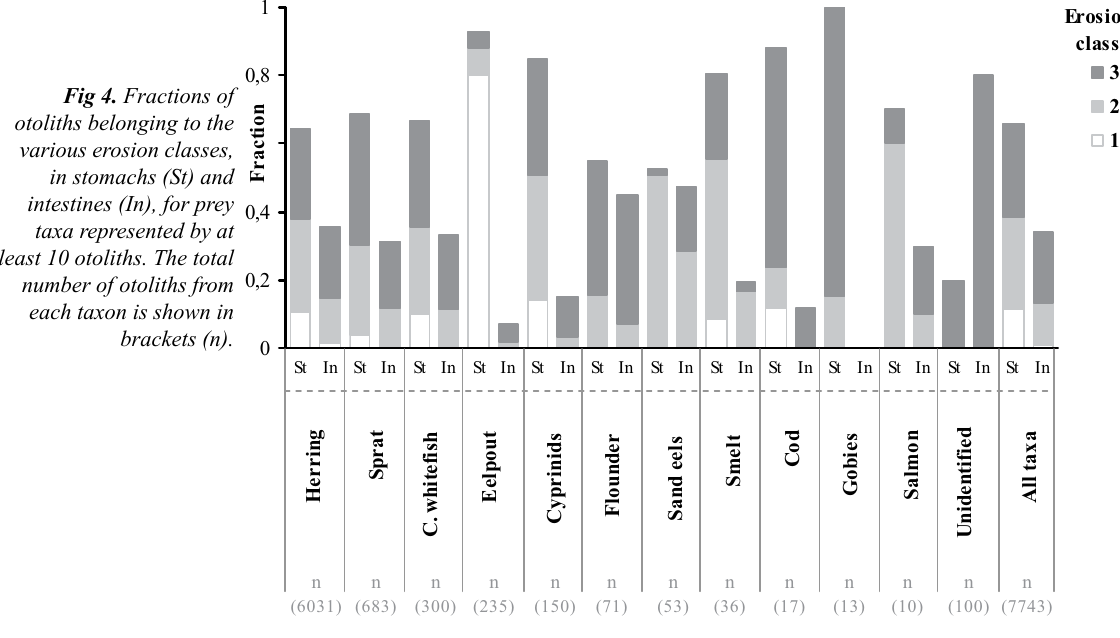
Fig 4. Fractions of n otoliths belonging to the o i various erosion classes, in stomachs (St) and intestines (In), for prey taxa represented by at least 10 otoliths. The total number of otoliths from each taxon is shown in brackets